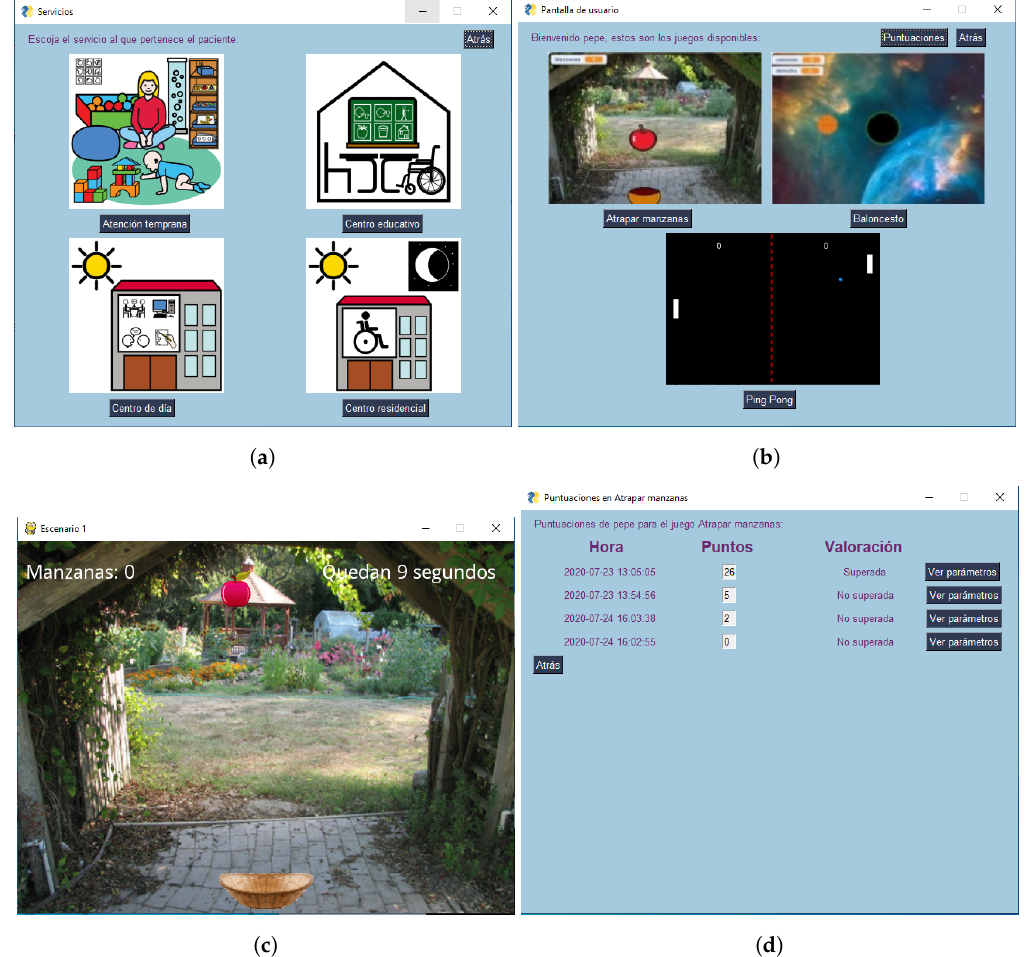
Figure 1. Developed tool: ( a ) Selection of services, ( b ) selection of games, ( c ) example of a game, and ( d ) user’s